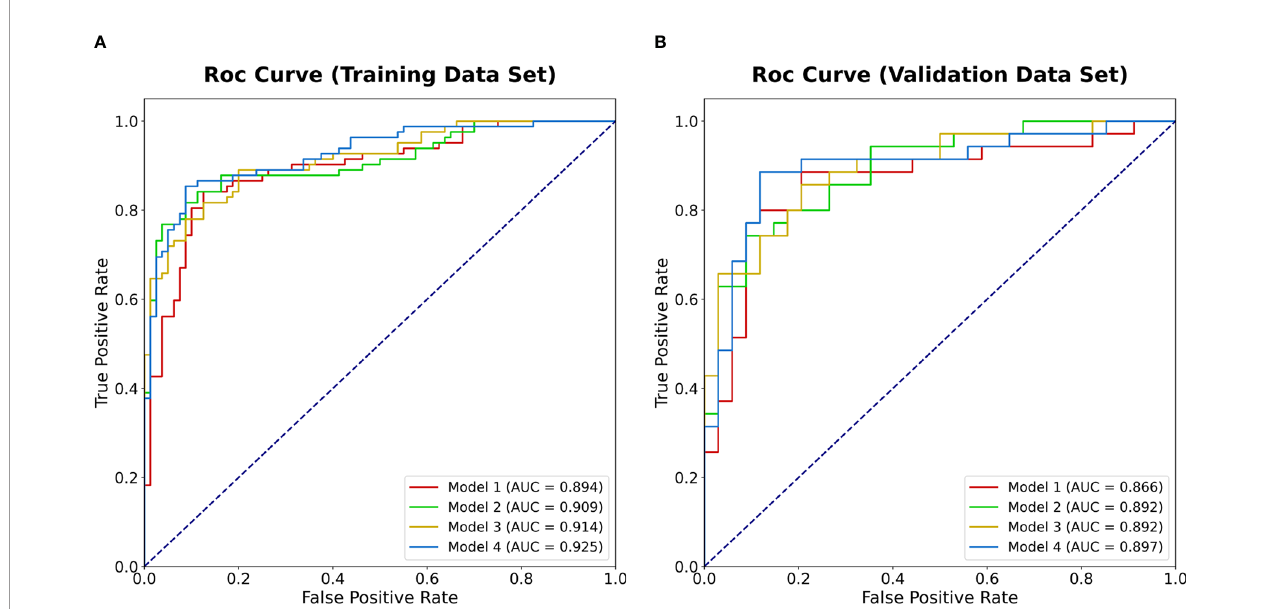
FIGURE 3 | The ROC curves of the four models in predicting malignancy potential of GISTs in the training data set (A) and the validation data set (B) . AUC, area under the receiver operating characteristic curve; GIST, gastrointestinal stromal tumors.